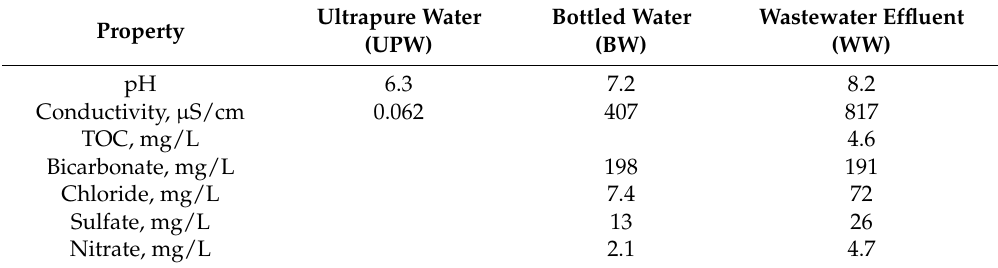
Table 1. Characteristics of the water